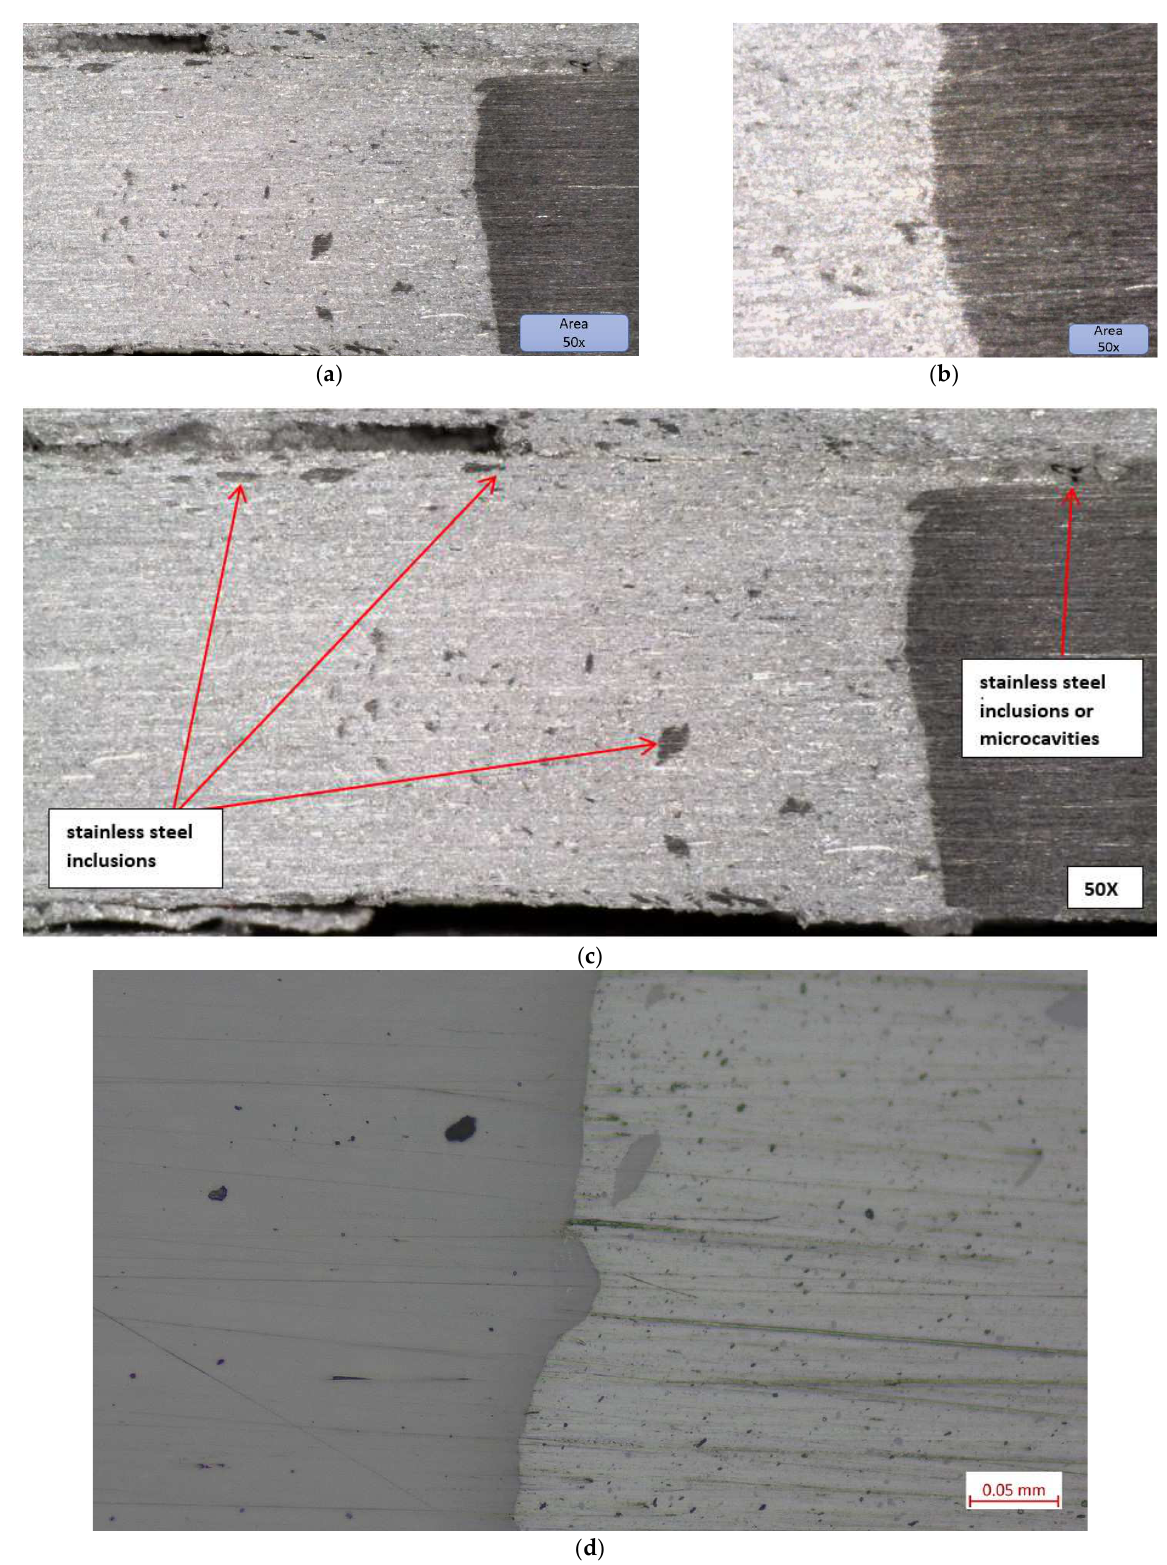
Figure 10. ( a ) Microscopic image of the aluminium area where the stainless-steel inclusions can be observed, ( b ) microscopic images of the joining area, and ( c ) microscopic image with stainless steel inclusions and microcavities. ( d ) Microscopic image at 200× with stainless-steel inclusions.